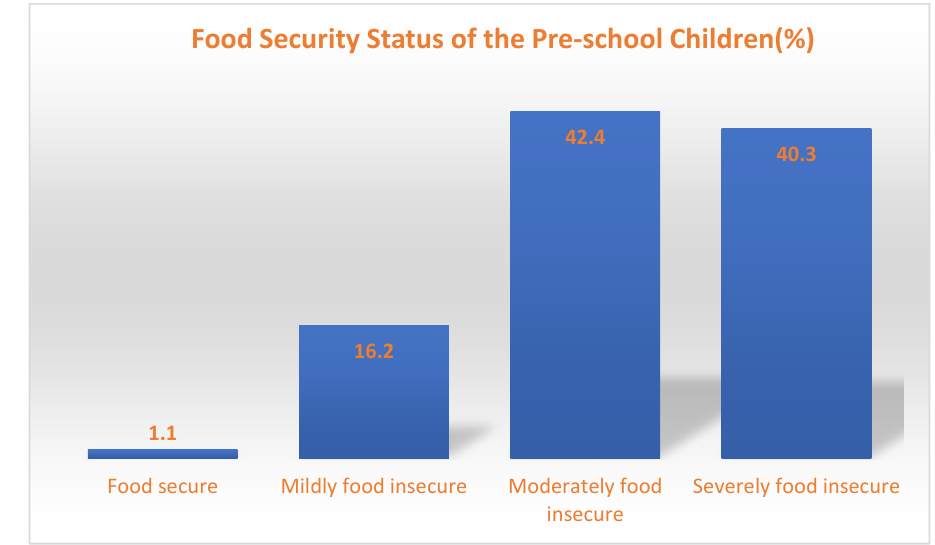
Figure 1. The prevalence of food security among the preschool children in Niger State, Nigeria. Table 3. Household Food Insecurity Access Score (HFIAS) of the preschool